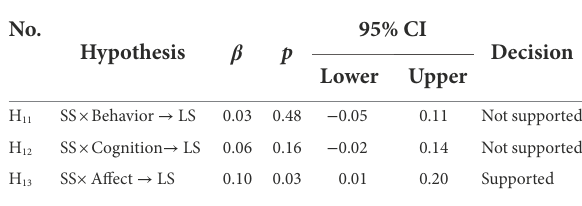
TABLE 5 Moderating effect of SS.